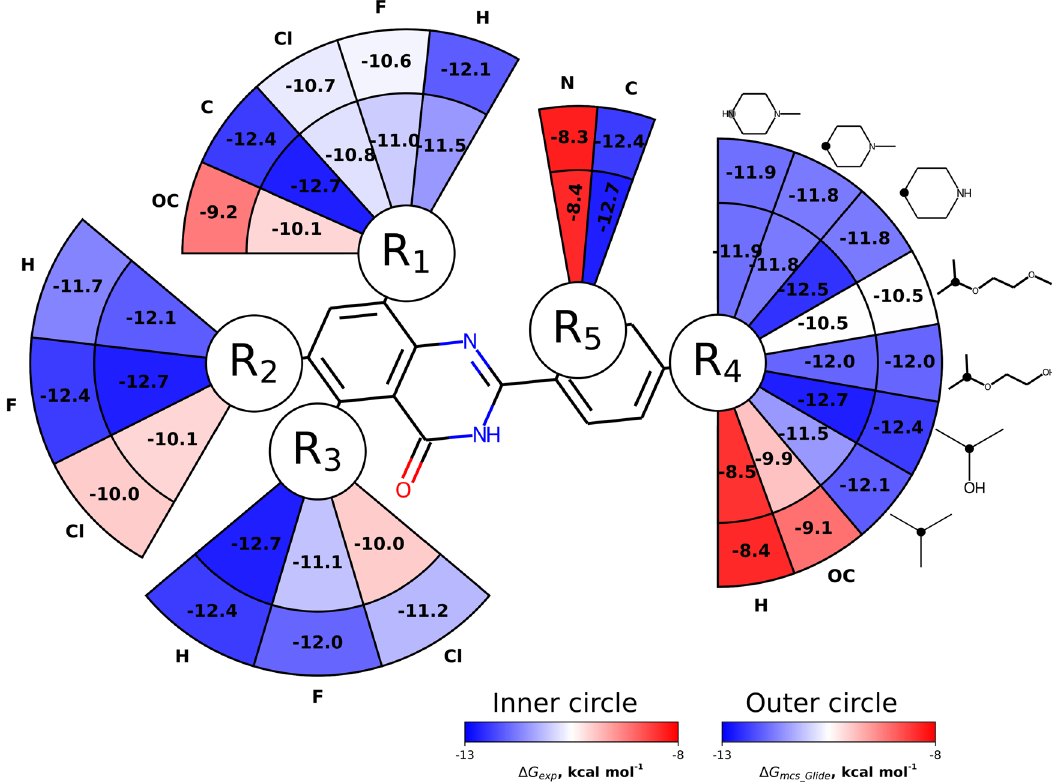
Fig. 6 Structure activity relationship (SAR) for the ligand series binding to TNKS2. The af fi nities of the strongest binder with the corresponding substituent at a given site are shown. Experimental Δ G is depicted in the inner circle. Calculation based on the poses from Glide MCS are shown in the outer